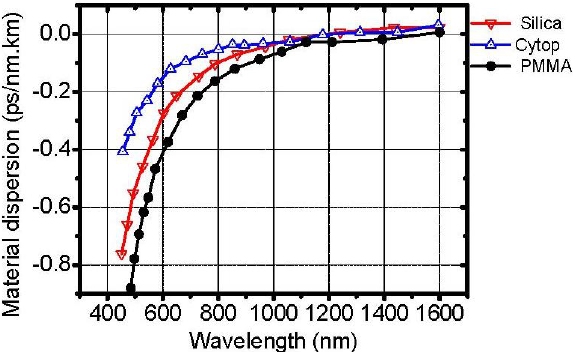
Figure 11. Material dispersion of glass and polymer fibers